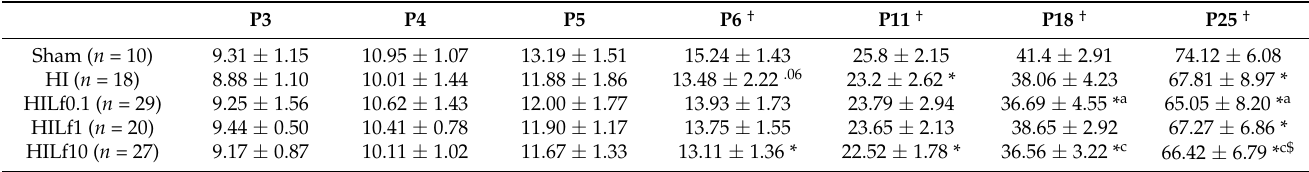
Table 2. Pup body weight monitoring during the experimental period. Litters were composed of 10 animals during experiments. Average weight (grams). † One-way repeated measures ANOVA * HI vs. Sham; $ effect of lactoferrin dose—HILf10 vs. HILf1; a c HILF0.1 or 10 vs. HI, respectively. Intra-day differences were determined by one-way ANOVA and considered significant when p <